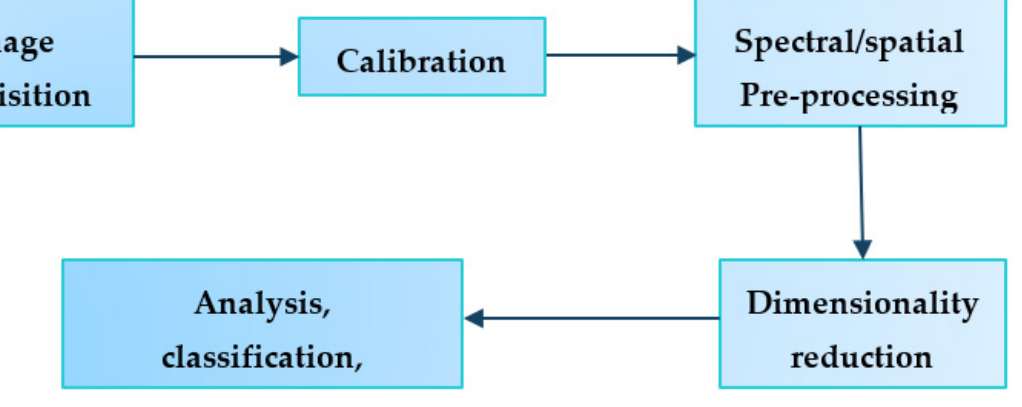
Figure 2. Hyperspectral image preprocessing workflow [42].